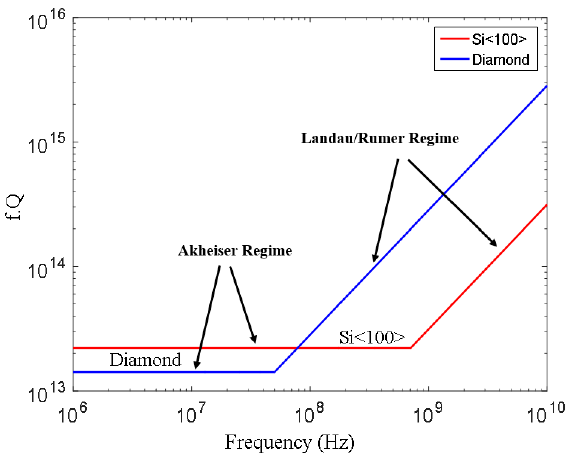
Figure 14. Limit of f . Q for a wide range of frequencies imposed by phonon scattering in diamond and <100> Silicon.